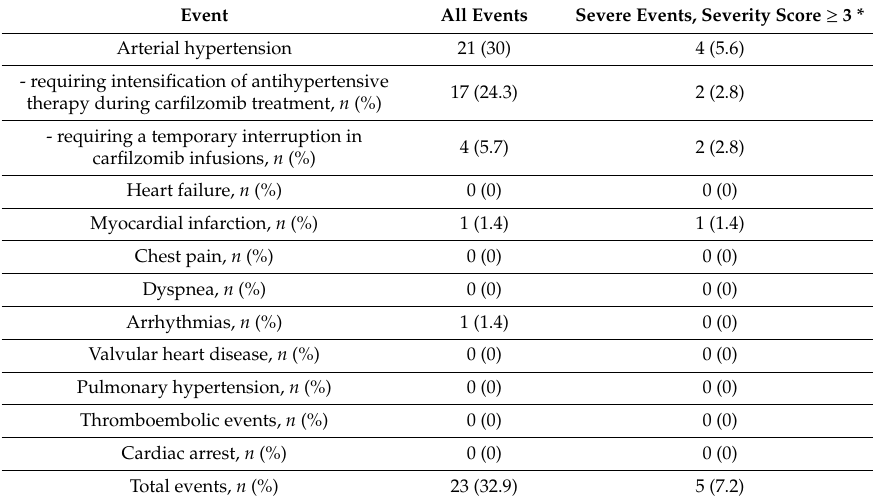
Table 3. Cardiovascular adverse events during and after carfilzomib treatment.